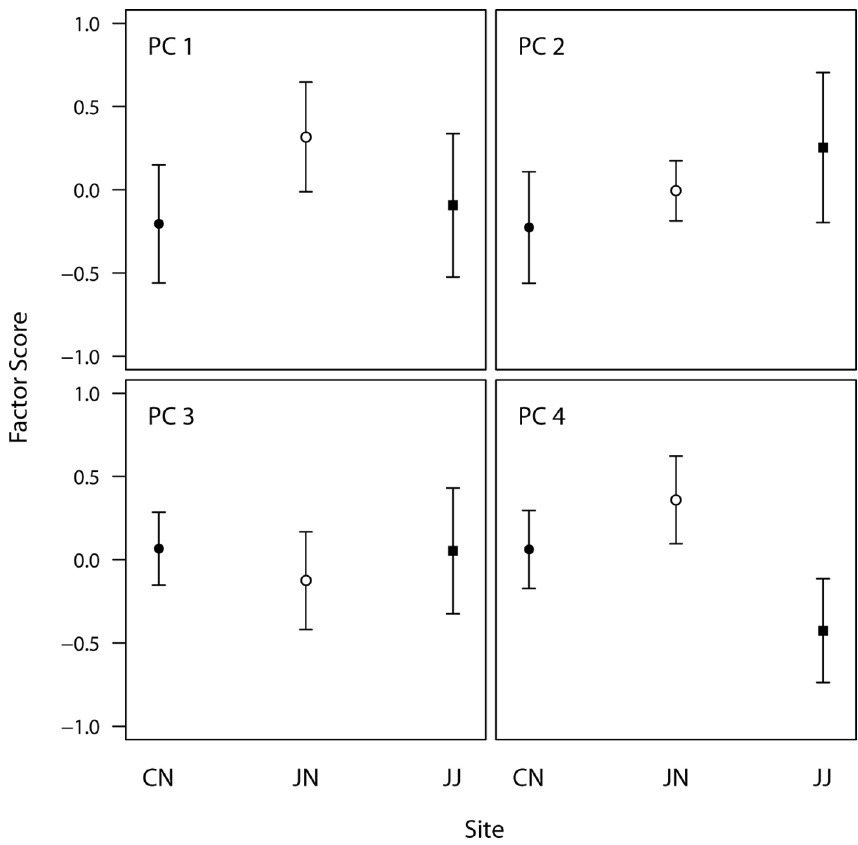
Figure 5. Comparison of the four component scores of male calls among three populations. Dots in the middle and error bars denote the average and standard error of component scores, respectively. All differences were insignificant.